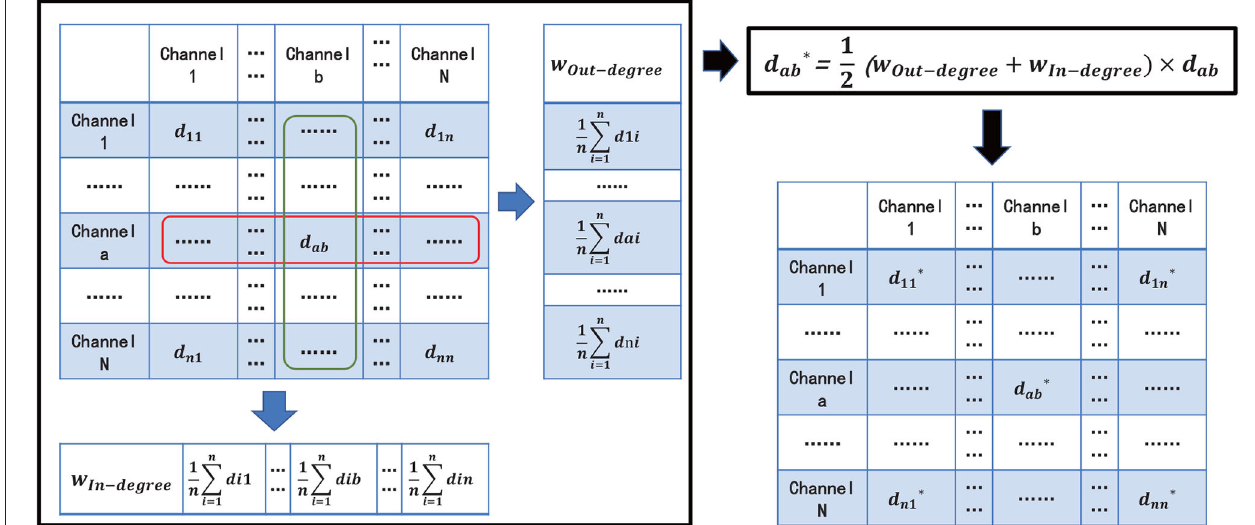
FIGURE 3 | Comprehensive EEG-FCV.